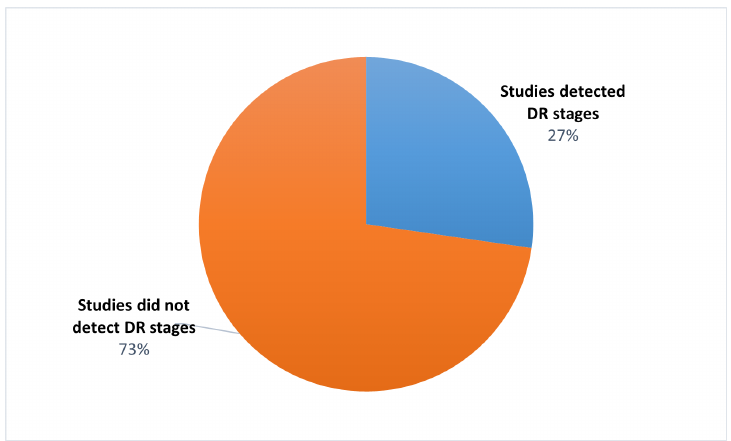
Figure 3. The ratio of studies that classified the DR stages